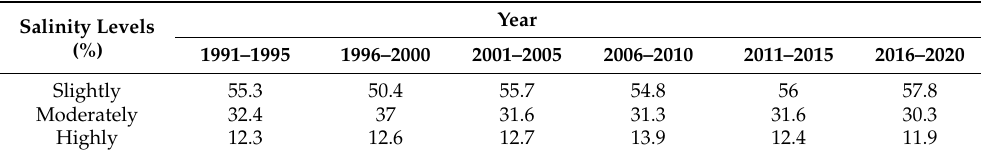
Table 2. Salinity areas in the Khorezm region from 1991 to 2020. Salinity Levels